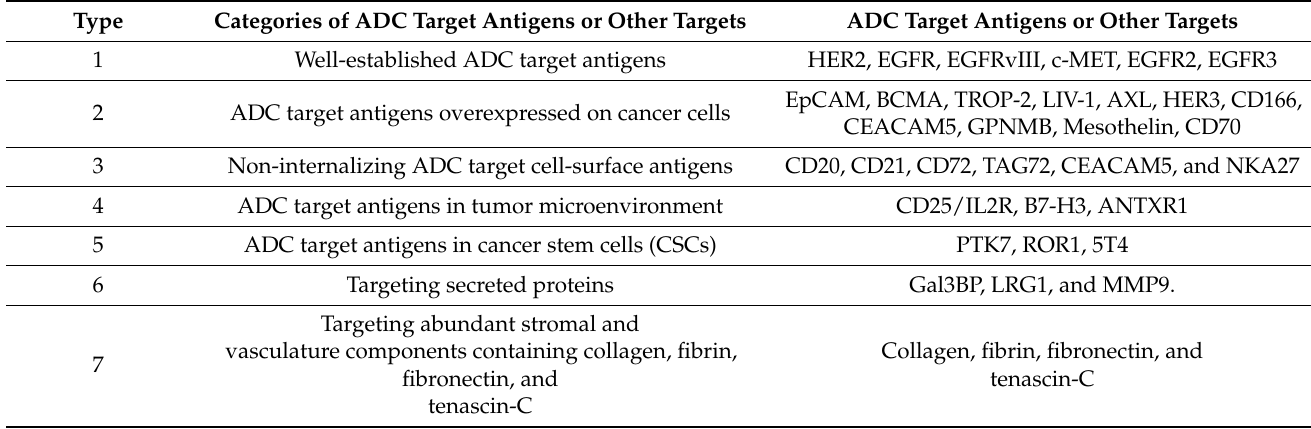
Table 1. ADC target antigens/proteins/stromal and vasculature components for the treatment of solid tumors.